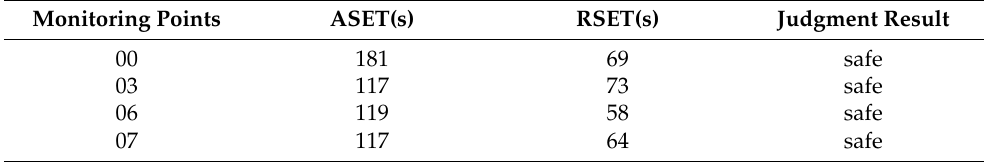
Table 10. Determination of evacuation results of fire monitoring points in the middle of platform.